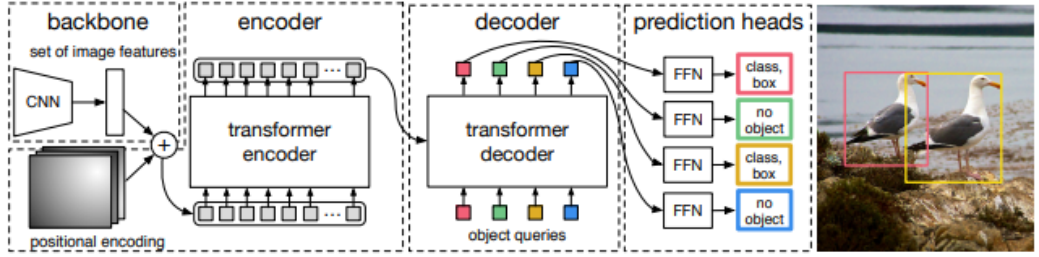
Figure 3. Illustration of design and functionality of the object detection method DETR. Image source of (Carion et al., 2020).